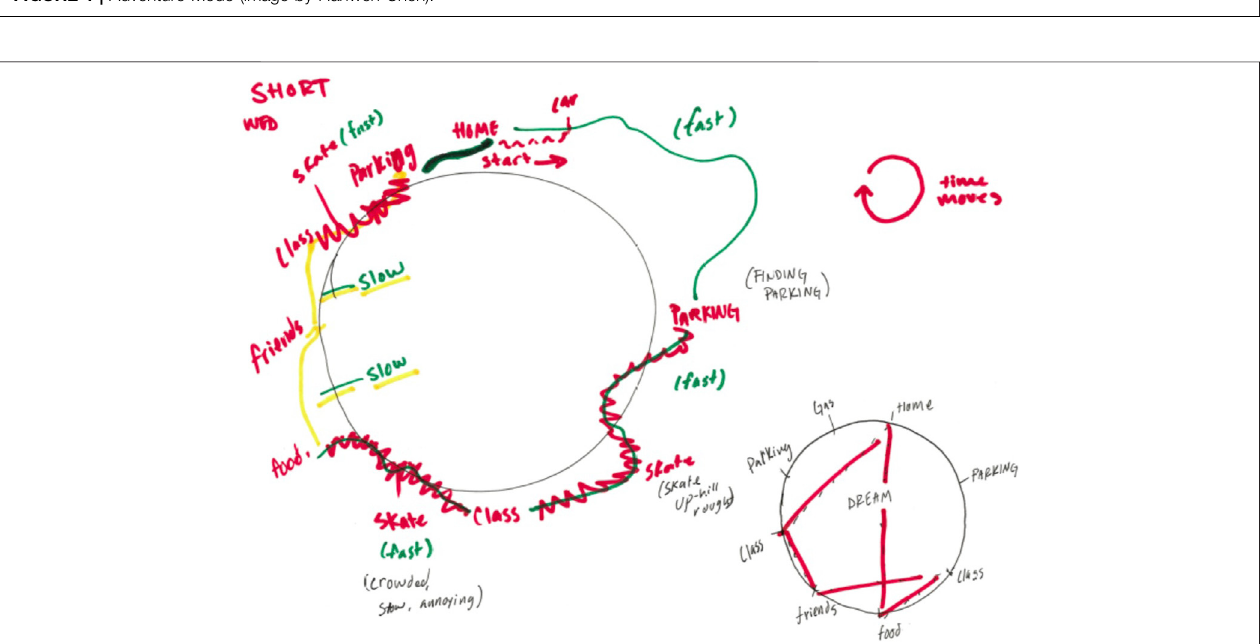
FIGURE2| ThisJourneyMapdepictsadayinthelifeofamobilityuser.Participantsmapanexperiencedday(largerupperleftimage)andanidealfutureday(small lower right image). Notice the future ideal with short, straight, extremely ef fi cient lines within the circle, in contrast to the more chaotic lines of the experienced